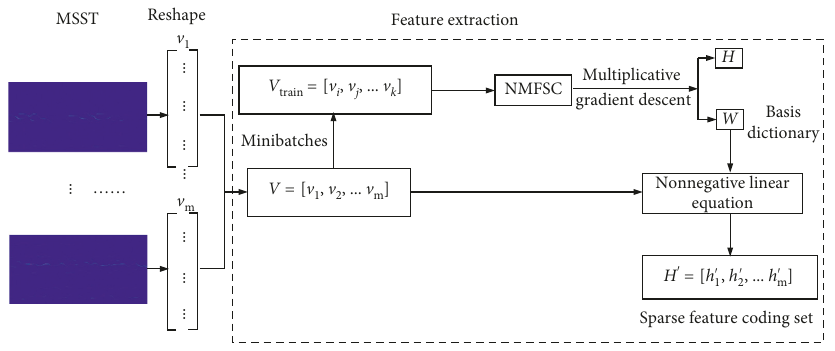
Figure 3: The flowchart of the feature extraction algorithm.